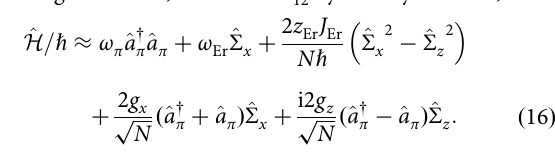
Figure 2a – c show the calculated phase diagrams as functions of T and B DC , applied along the a , b , and c axes, respectively. The (cid:3) (cid:2) σ B j in the z components of the thermal difference j (cid:2) σ A z z equilibrium values of Er 3 þ spins (AFM vector) is plotted in red. j (cid:2) σ A (cid:3) (cid:2) σ B j is the order parameter for the LTPT in the presence of z z